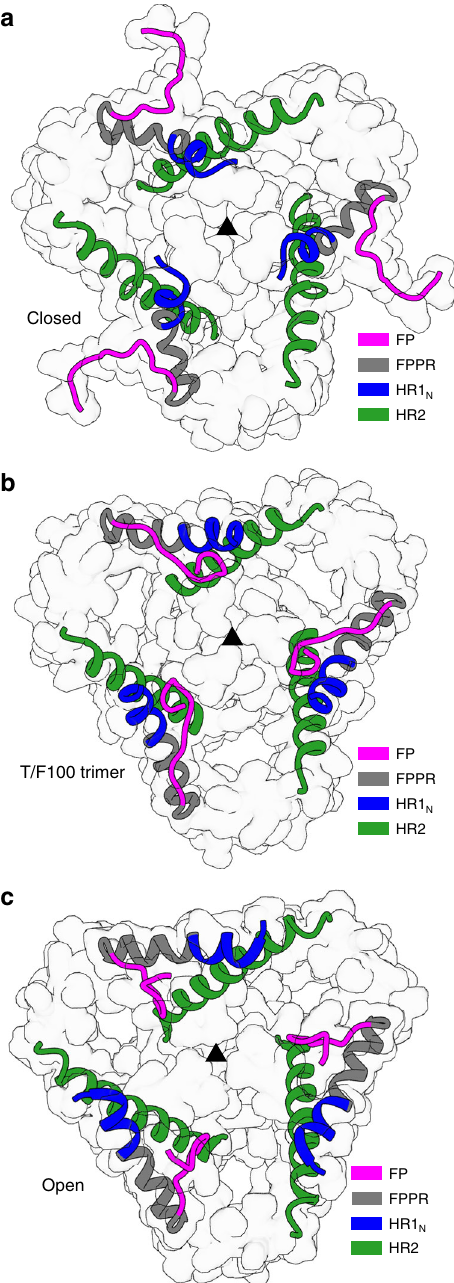
Fig. 3 FP and HR1 N conformation of HIV-1 Env trimer structures. a – c FP and HR1 N conformation of a the closed trimer structure (PDB accession code 5I8H), b the T/F100 trimer structure and c the open trimer structure (PDB accession code 5VN3). Only gp41 of each trimer structure are shown for clarity. The FP, FPPR, HR1 N , and the C-terminal part of HR2 (residues 637 – 664) regions of the trimer structures are shown as ribbon diagrams and semitransparent surfaces. Other parts of gp41 are shown only as surface representations. The three-fold axis of each structure is identi fi ed by a solid black